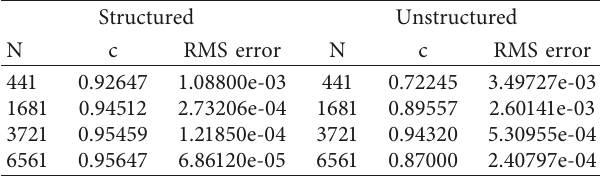
Table 5: The RMS error for problem